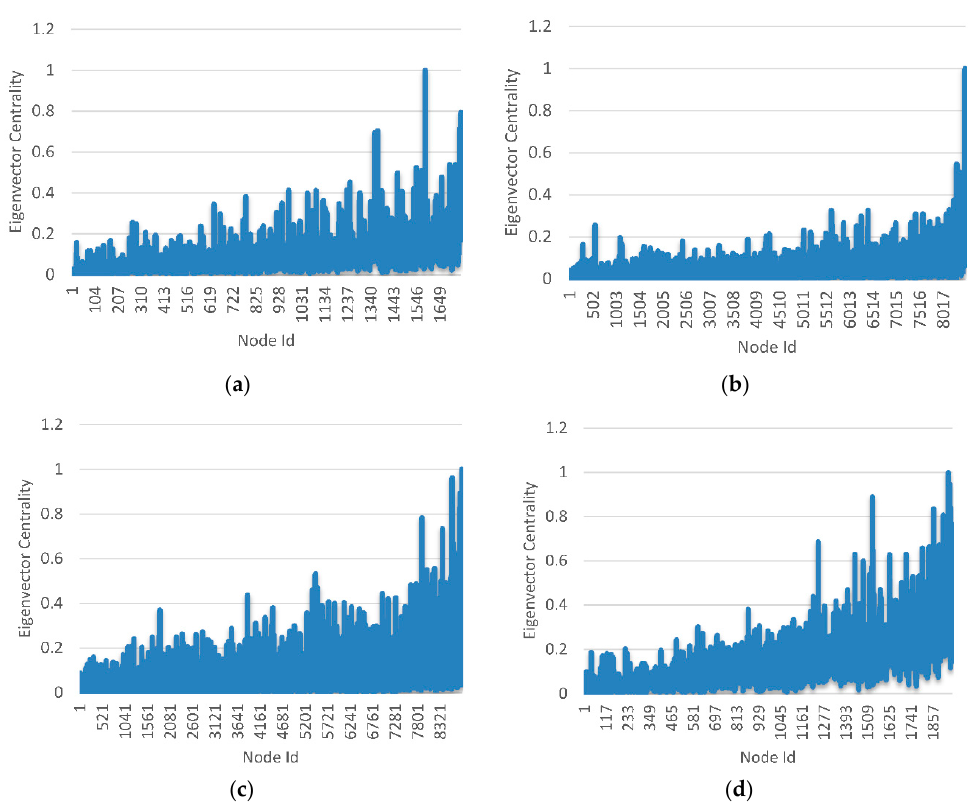
( d ) Figure 9. Centrality sorting of sandstone pore nodes: ( a ) 14.1%; ( b ) 16.9%; ( c ) 17.1%; ( d ) 24.6%.